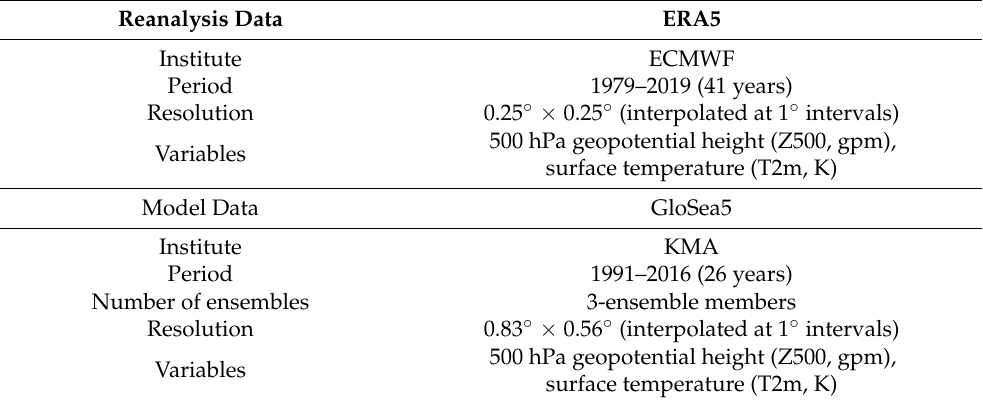
Table 1. Reference for information of the ERA5 (ECMWF Reanalysis 5th Generation) and the GloSea5 (Global Seasonal Forecast System version 5) seasonal prediction models referred to within the